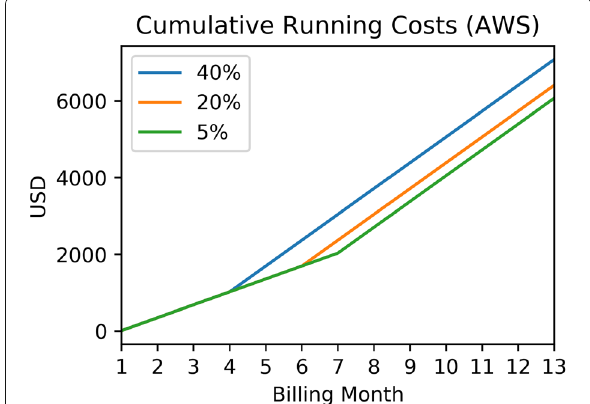
Fig. 7 Cumulative cost for an AWS deployment of Apache OFBiz